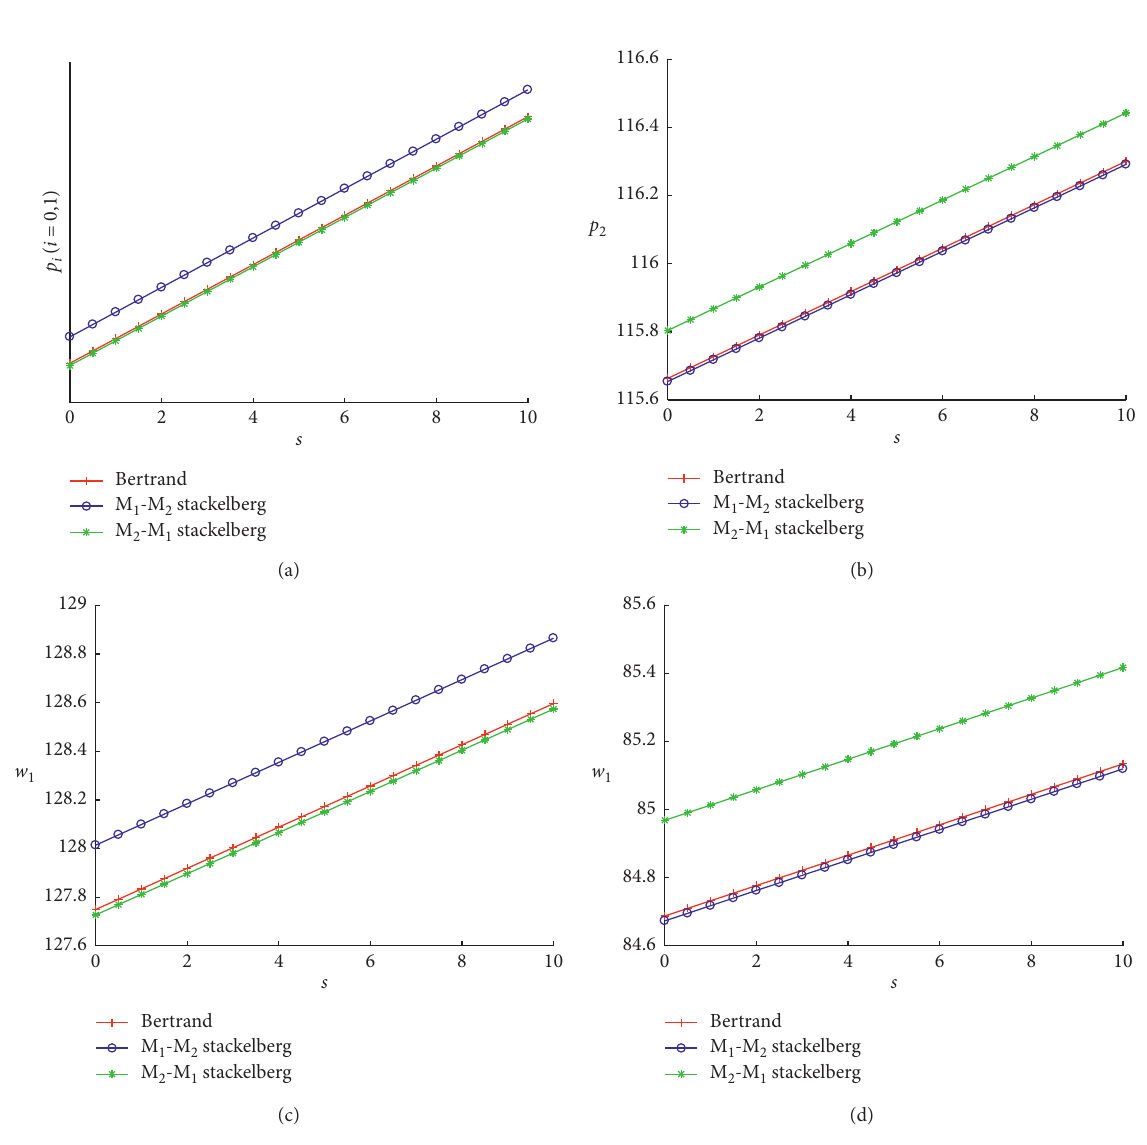
Figure 2: Influence of s on price functions under different